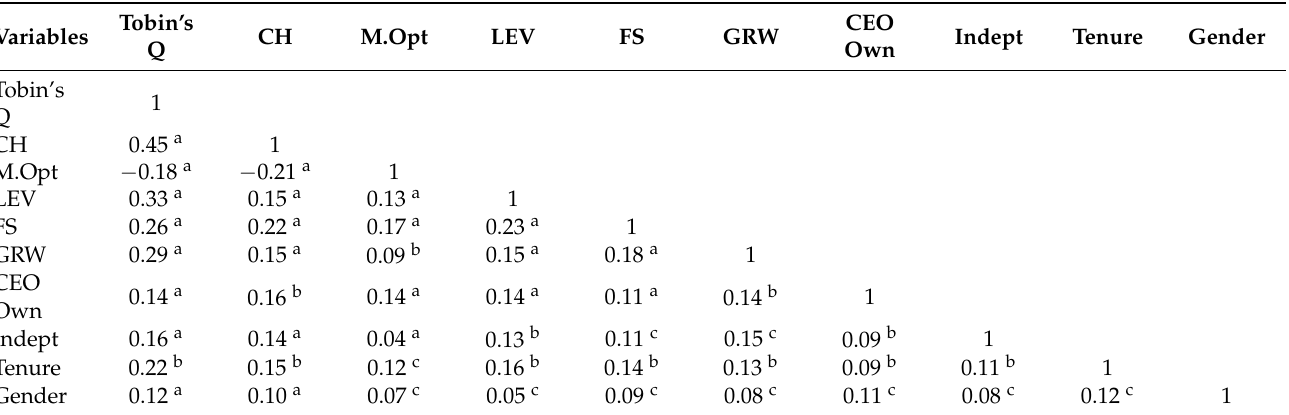
Table 7. Correlation matrix of the financially unconstrained